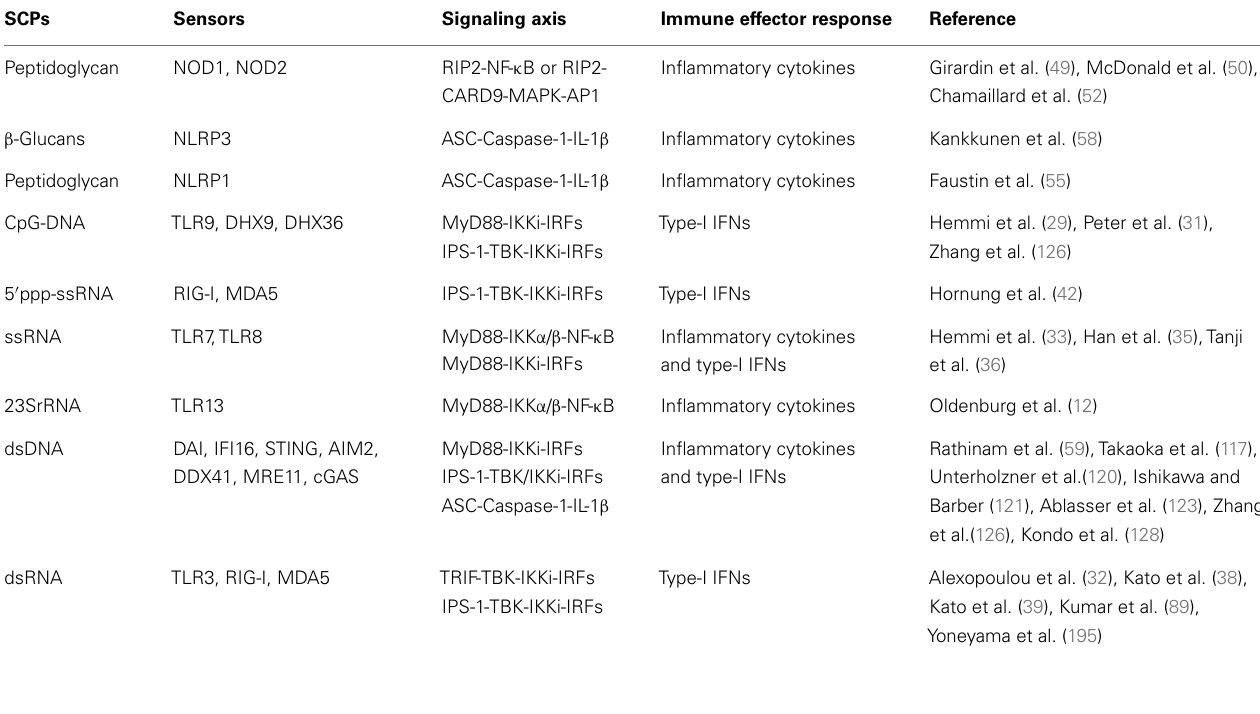
Table 2 | Sensing of SCPs by cytosolic